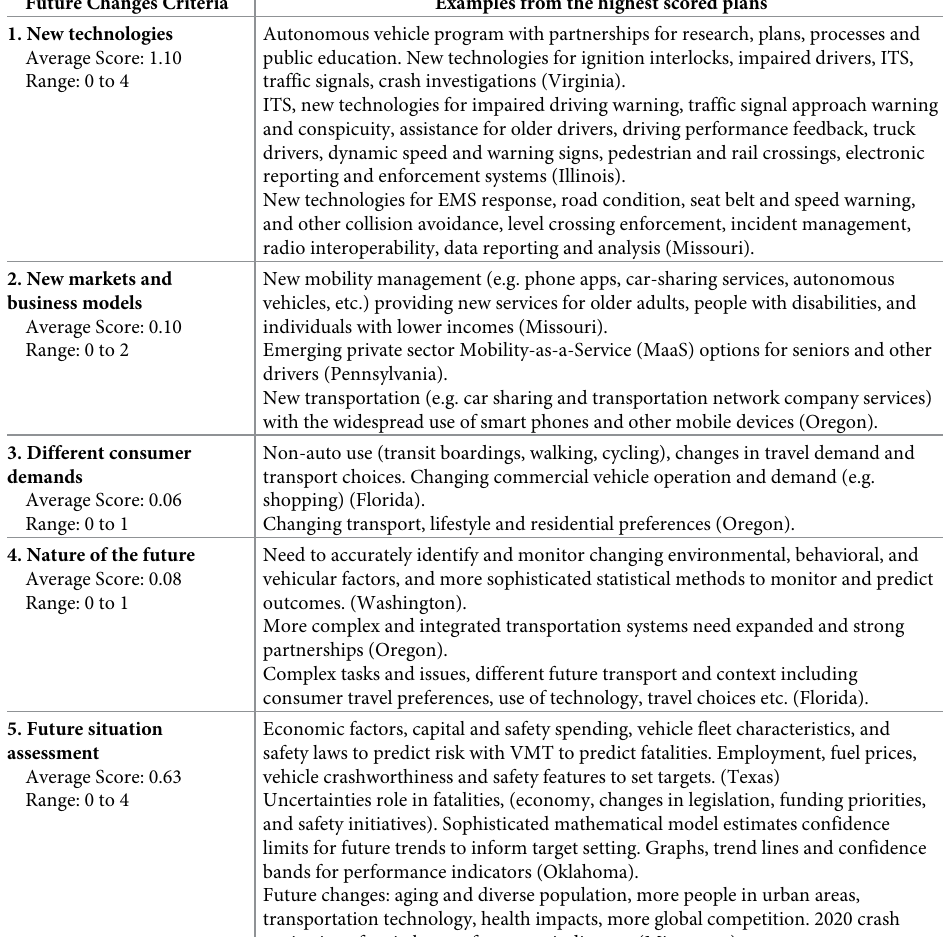
Table 5. Summary of future changes criteria